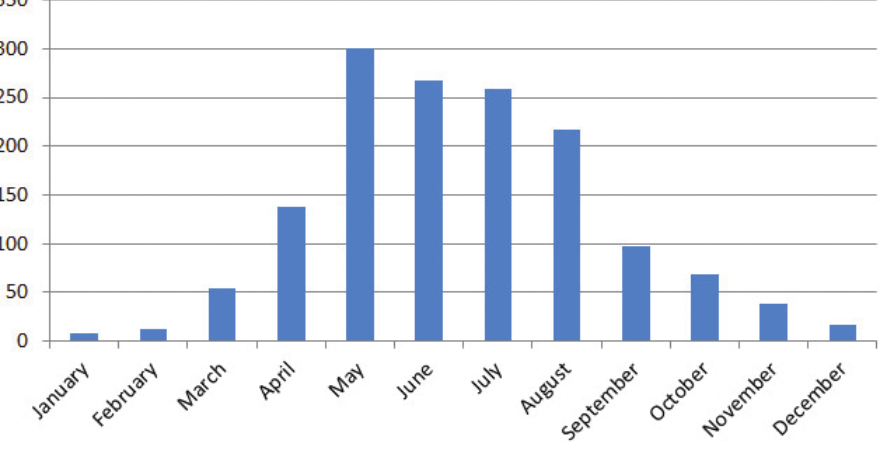
Figure 8. Collecting months according the specimens